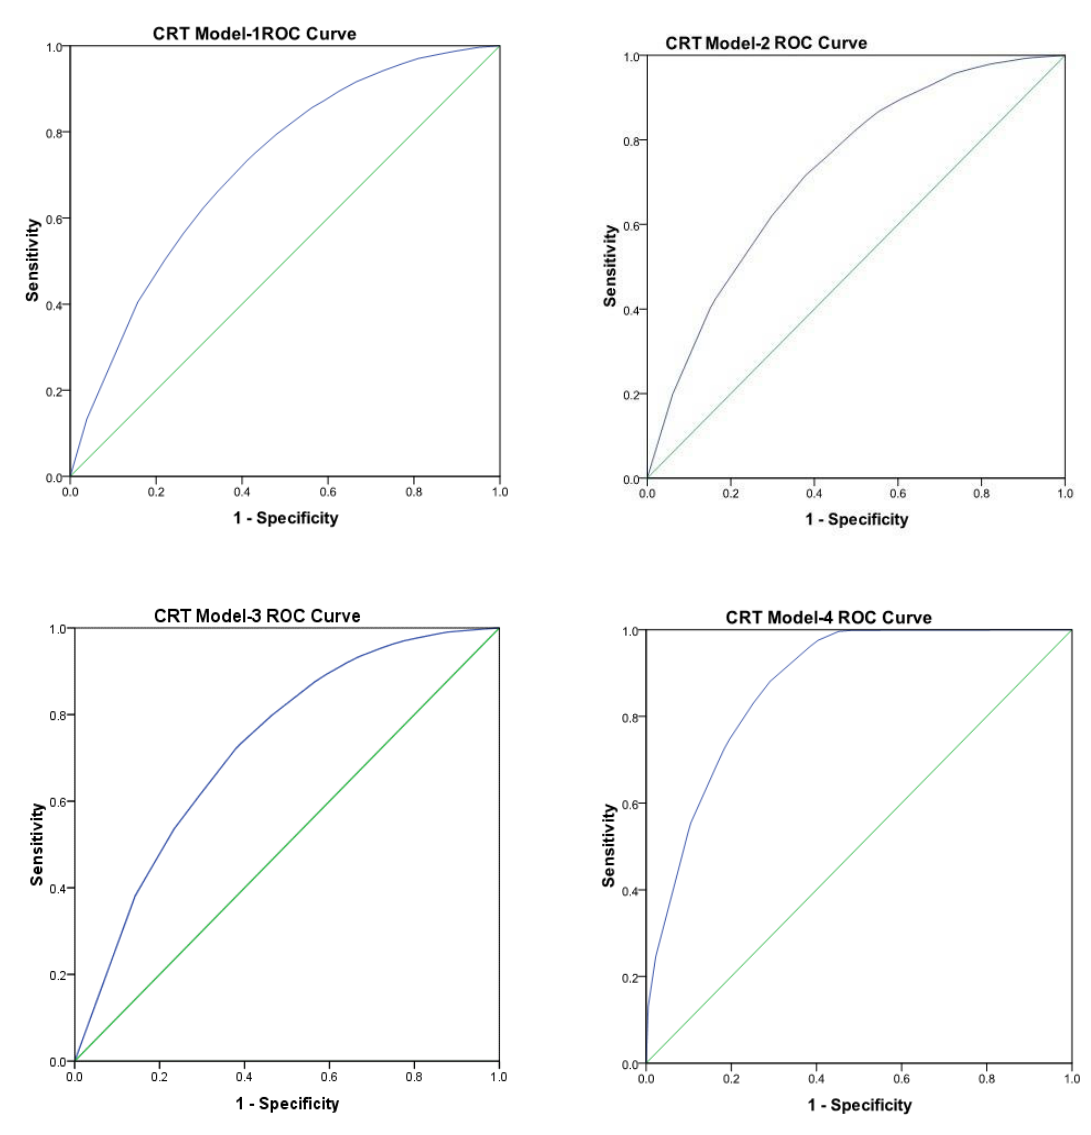
Figure 4. ROC areas for CRT based Decision